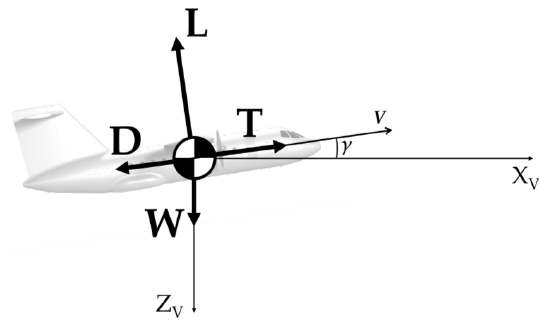
Figure 4. Force schema.